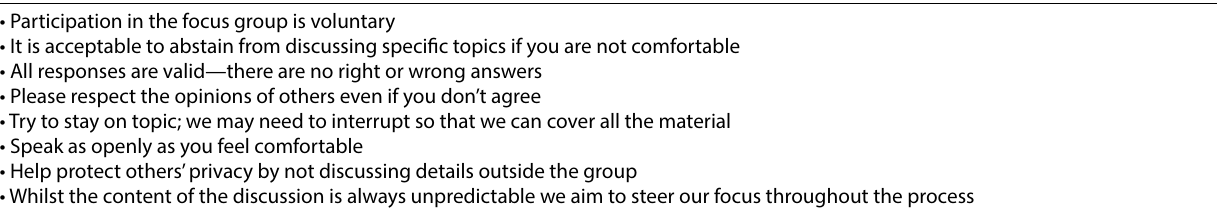
Table 2 Focus group rules of engagement